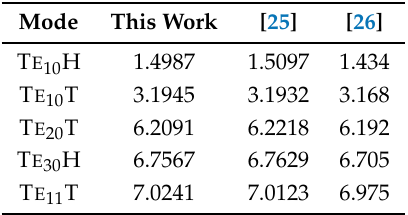
Table 5. Cutoff wavenumbers κ c [ rad · cm − 1 ] for the double-ridged